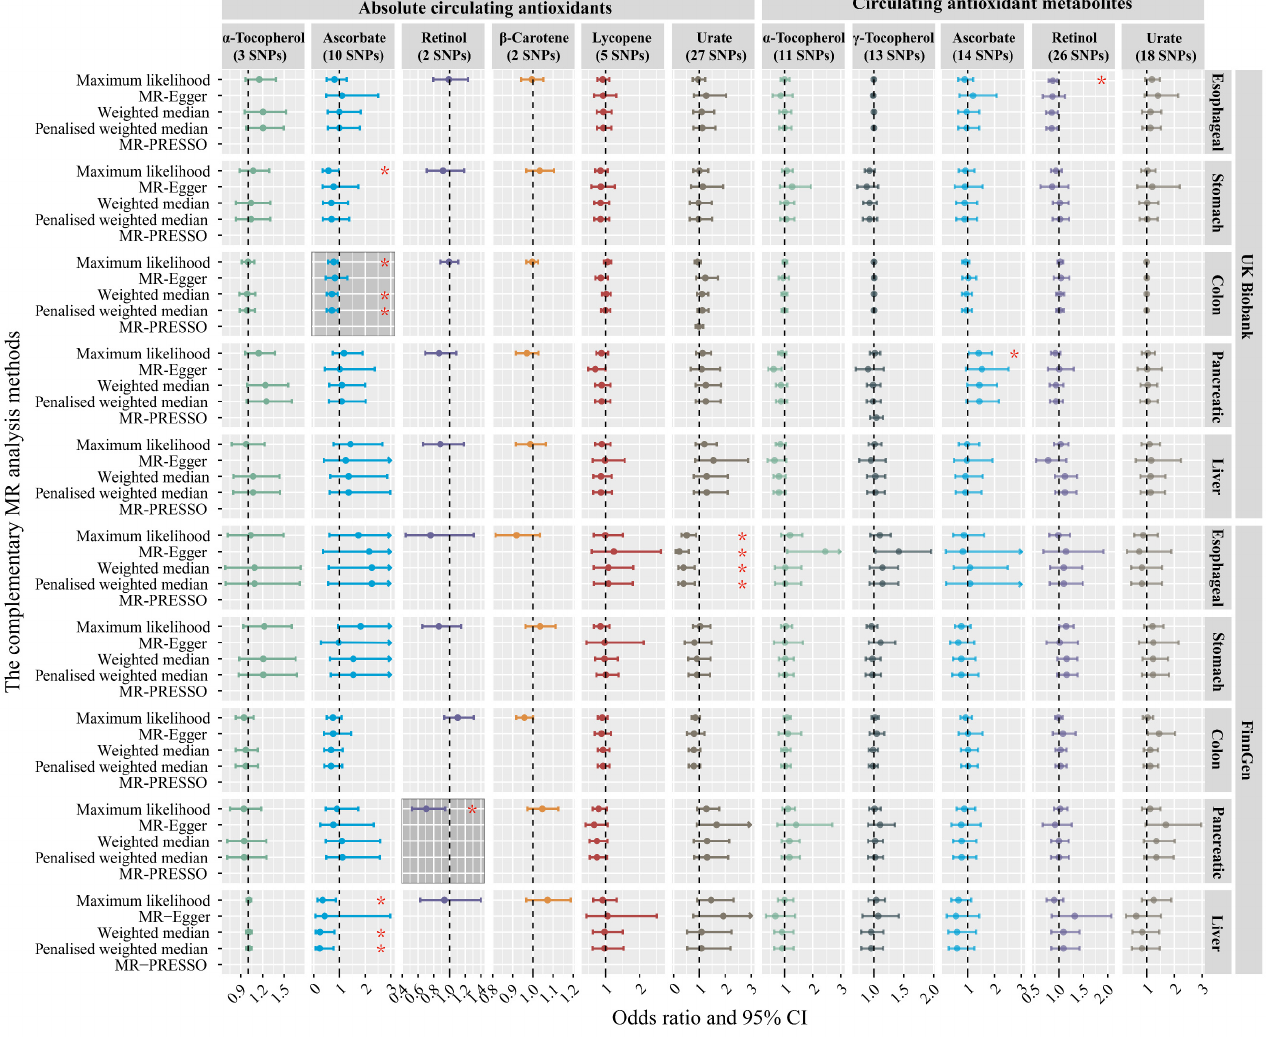
Figure 4. The complementary MR analyses results of the causal effects of diet-derived circulating antioxidants on five digestive system cancers. The MR-Egger, weighted median, and penalized weighted median required the number of SNPs in the instrumental variable > 2, and MR-Egger method could not accurately estimate due to collinearity in MR analyses for α -tocopherols. The MR- PRESSO requires the number of SNPs in the instrument variable > 3. If the MR-PRESSO global test did not identify significant outliers in the genetic instrument, the MR-PRESSO did not require correction. The error bars indicate 95% CIs. Statistical significance was defined as Bonferroni-corrected threshold of p -value < 0.01 (0.05/5), and p -value between 0.01 and 0.05 was considered suggestive evidence (*) of associations. Shaded areas represent suggestive evidence from meta-analysis, combining UK Biobank and FinnGen.